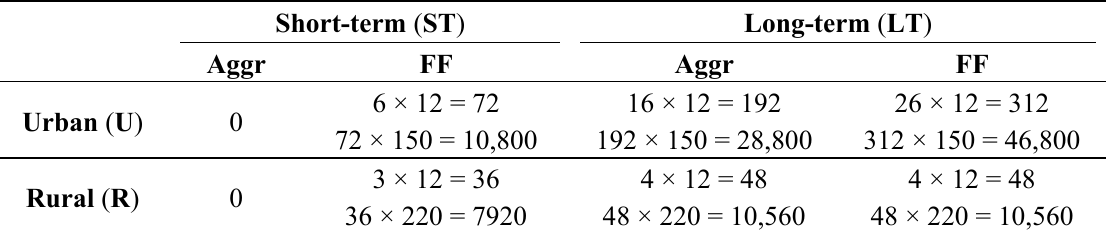
Table 8. Difference of cost (in €) per CNTR and per district during one year between using IPSec and TLS/SSL in each scenario.